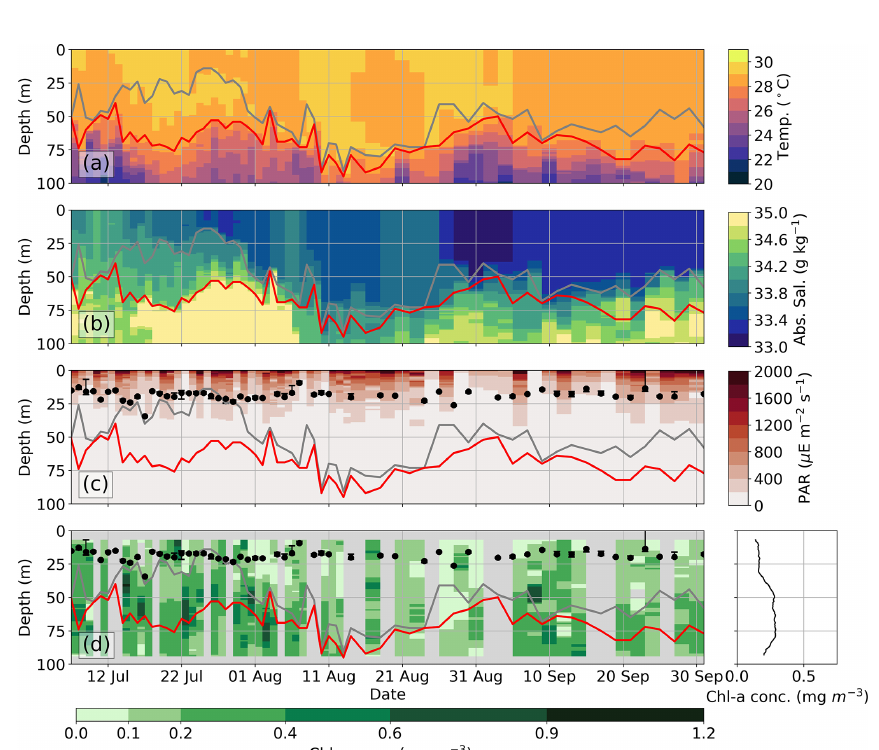
Figure 7. As Fig. 6 but for float 629.